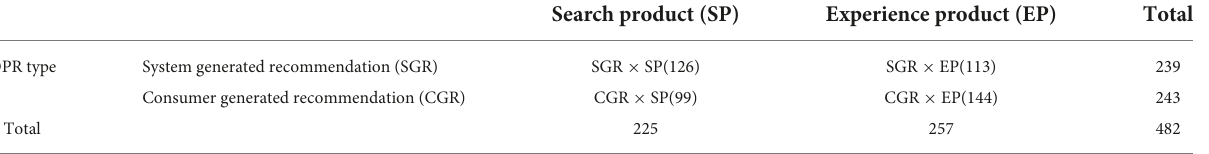
TABLE 4 2 × 2 between-respondents factorial